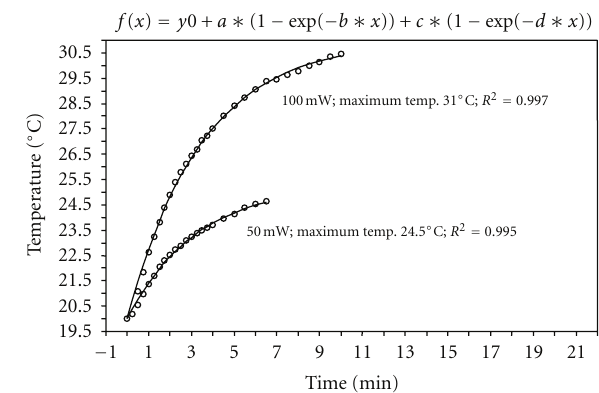
Figure 4: Temperature change in H 2 O with the CO 2 laser, pulsed, repetition rate